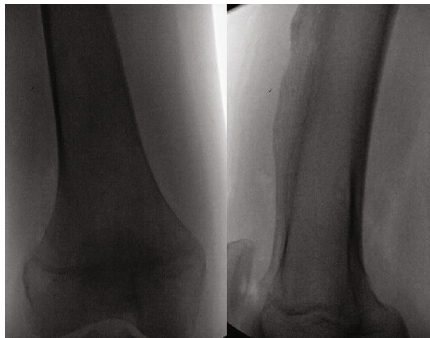
Figure 9: AP and lateral intraoperative fl uoroscopic images showing further resection and smoothing of the distal femoral